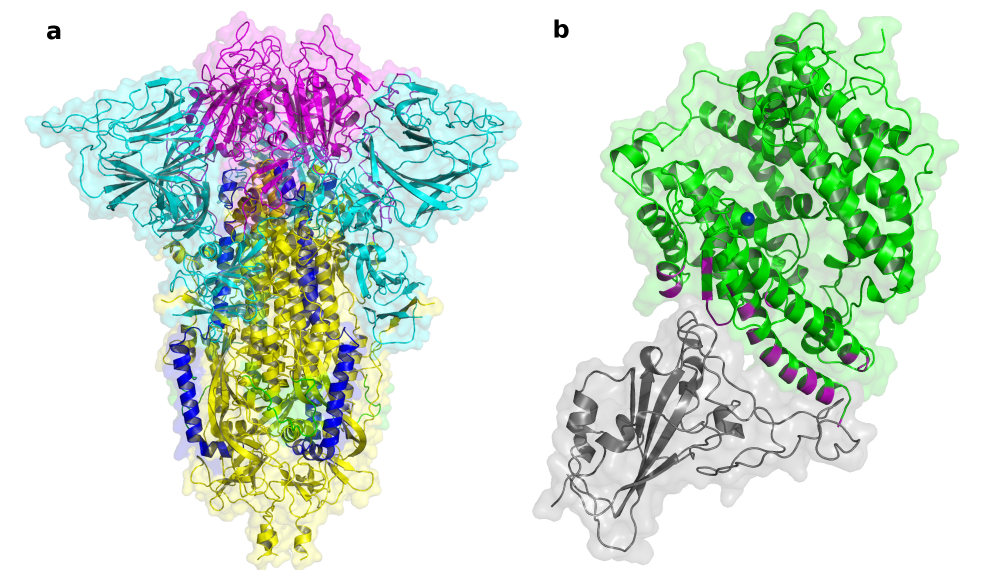
Figure 3. ( a ) Cryo-electron microscopy structure of SARS-CoV-2 spike protein (residues 1-1147— PDB ID: 7DCC). Spike protein domains are color coded as follows: S1—cyan; RBD—magenta; S2—yellow; FP—green; HR1—blue [53]. ( b ) X-ray crystal structure of ACE2 bound to SARS-CoV-2 spike protein (PDB ID: 6M0J). ACE2 is depicted in green cartoons, with the spike/ACE2 interface residues highlighted in magenta and the zinc atom represented by a blue sphere. Spike protein RBD is depicted in gray [54]